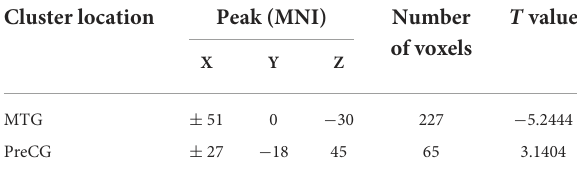
TABLE 2 Signification differences in VHMC values between the groups. Cluster location Peak (MNI)